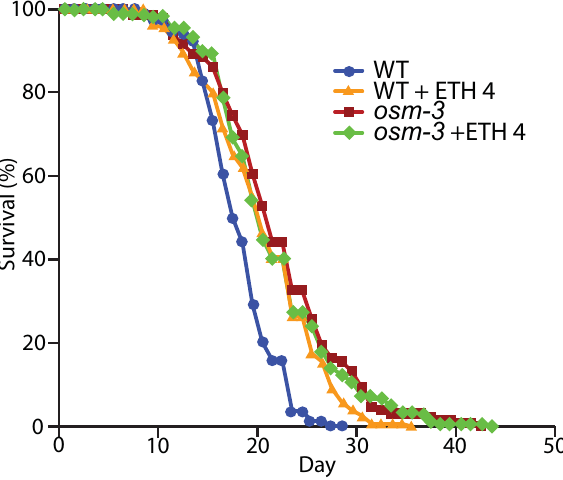
Figure 7. osm-3 mutants were long-lived and failed to respond to lifespan extension by ethosuximide. Wild-type (WT) or osm- 3(p802) hermaphrodites were cultured with 0 mg/ml or with 4 mg/ml ethosuximide ( + ETH 4) from conception until death. Day 0 represents the L4 stage.